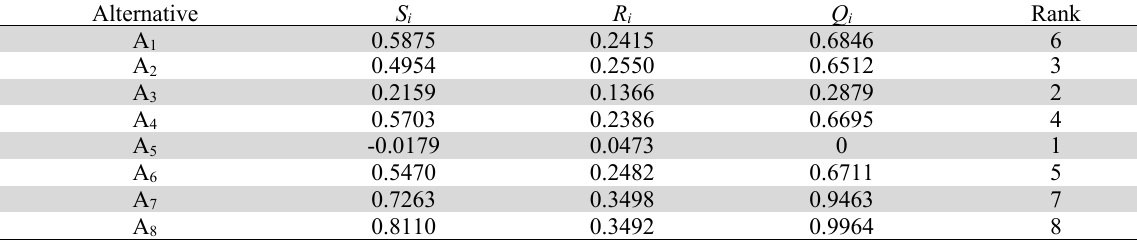
Ranking of material alternatives in fuzzy VIKOR method